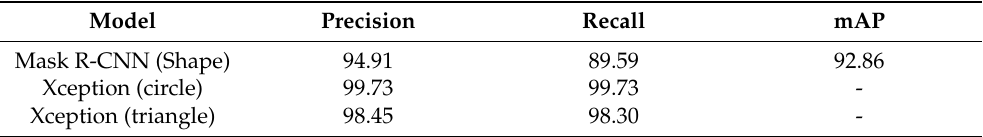
Table 8. Results of all models in our